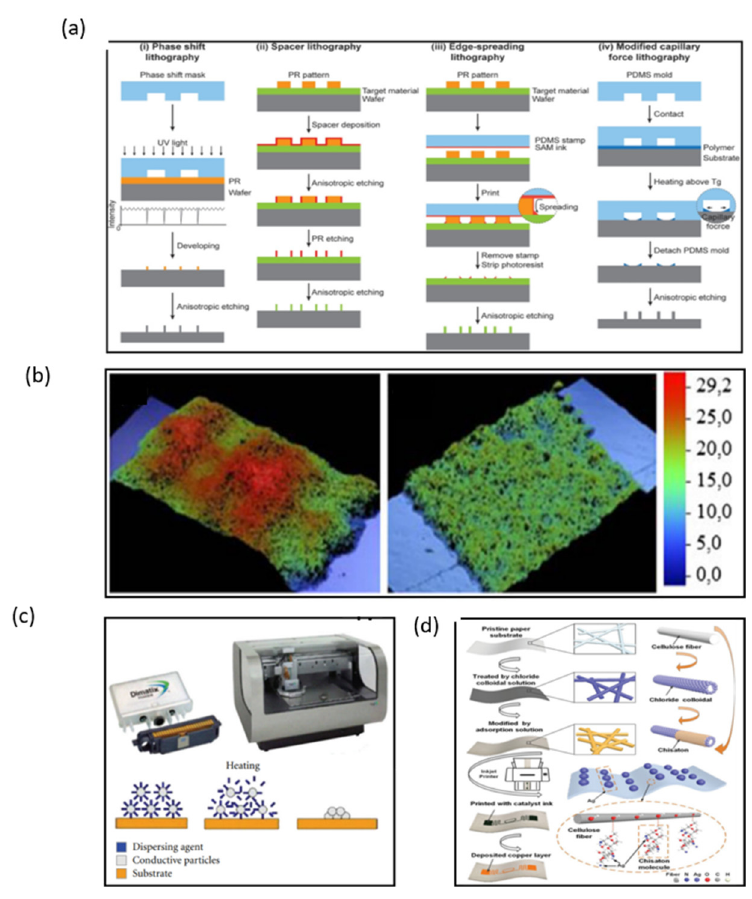
Figure 6. ( a ) Four different edge lithography approaches based on methods for utilizing the edge [32]. ( b ) Microphotographs of screen-printed lines with a mesh of 43 T/cm and 140 T/cm [35]. ( c ) Cartridge and Printer Dimatix 2831 and sintering process [37]. ( d ) Fabricating flexible RFID tags on paper substrates via inkjet printing, surface modification, and electroless deposition [38]. ( a ) Reprinted with permission from Ref. [32]. Copyright© 2022, John Wiley and Sons. ( b ) Reprinted with permission from Ref. [35]. Copyright© 2022, Springer Nature. ( c ) Reprinted with permission from Ref. [37]. Copyright© 2022 I. Ortego et al. ( d ) Reprinted with permission from Ref. [38]. Copyright© 2022 WILEY ‐ VCH Verlag GmbH & Co. KGaA, Weinheim.